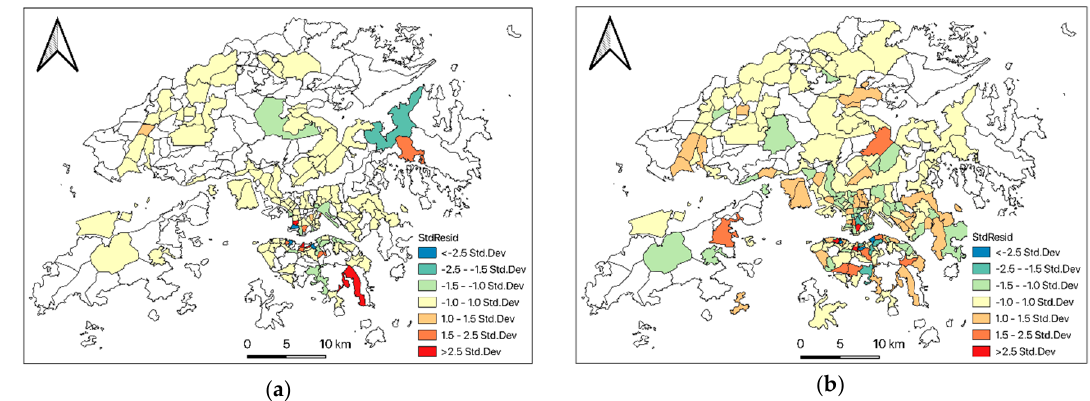
Figure 7. Spatial distribution of local standard residual from the GPWR models for R1 and R2: (a) Local standard residual R1; (b) Local standard residual R2.